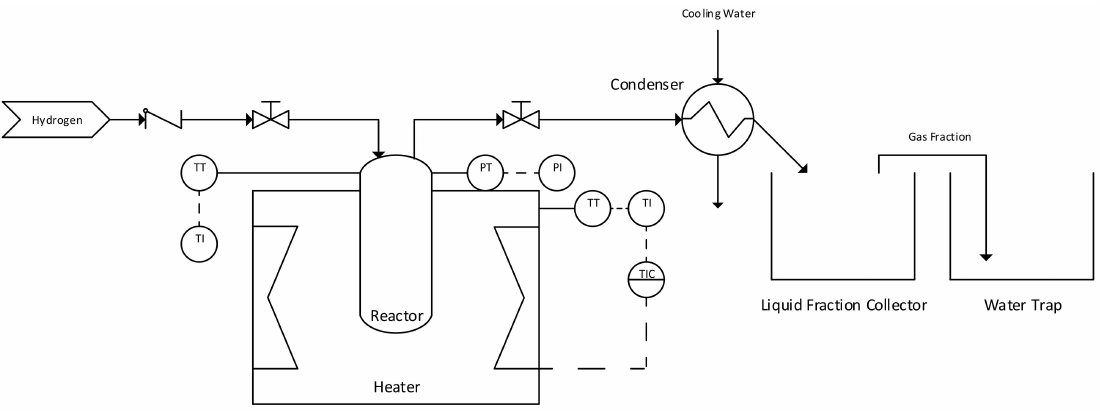
Figure 1. Pyrolysis set